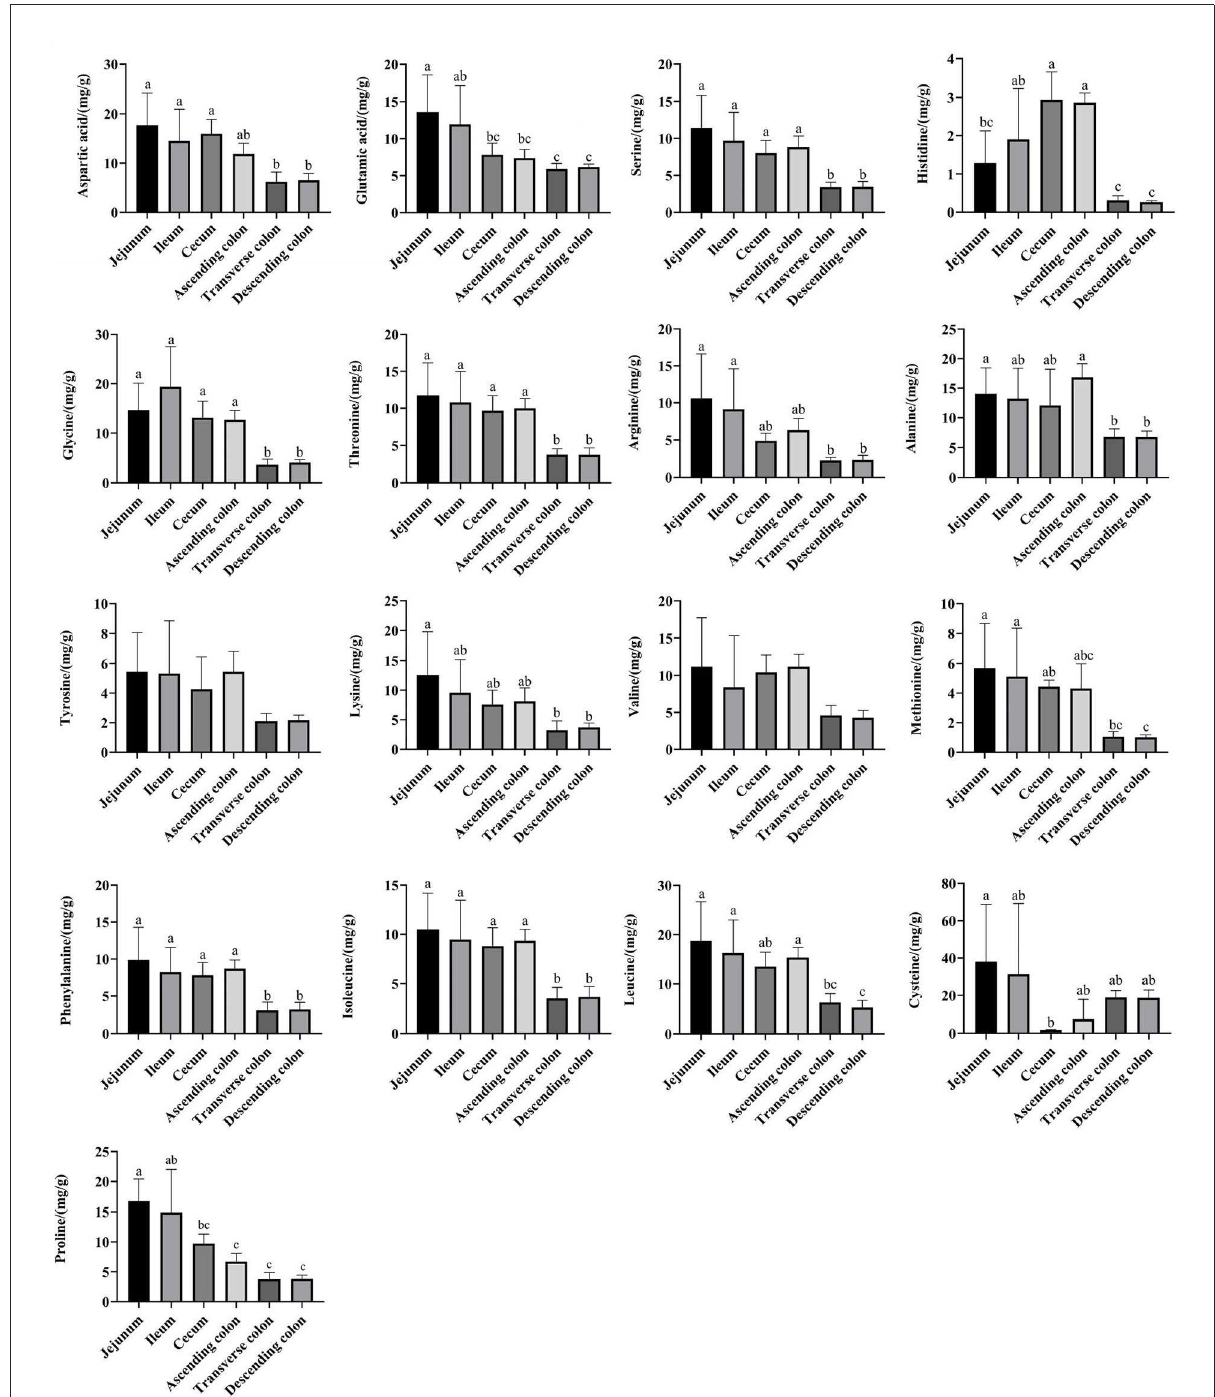
FIGURE9 The concentrations of amino acids in different intestinal locations of pigs. The concentration was based on the dry matter of the intestinal contents. Data are shown as mean ± SD ( n = 6). The same letter within each column indicates no significant difference ( p > 0.05).